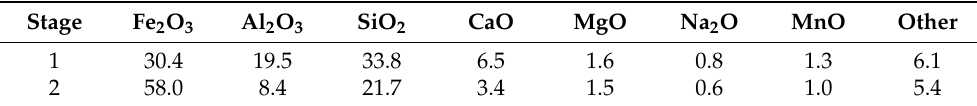
Table 3. Chemical composition of the iron-containing component after each magnetic separation stage.